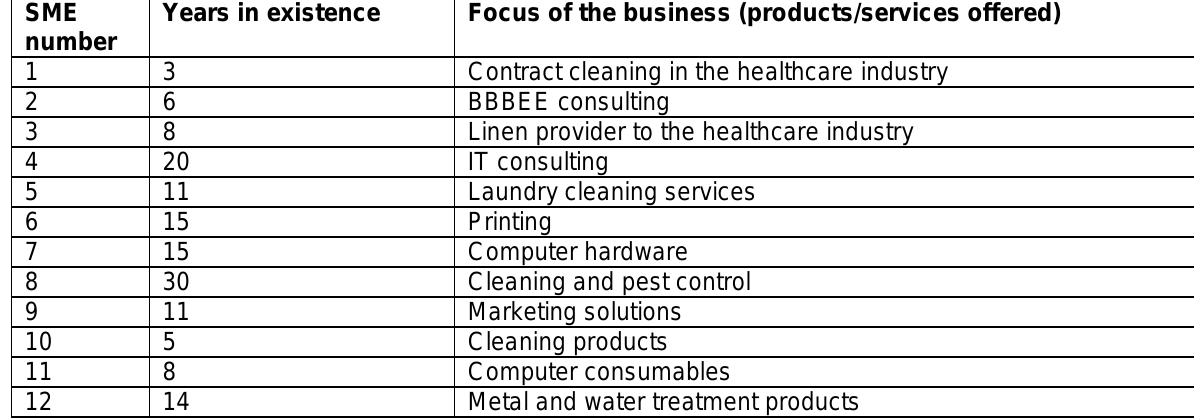
Table 3: Critical cases included in the study